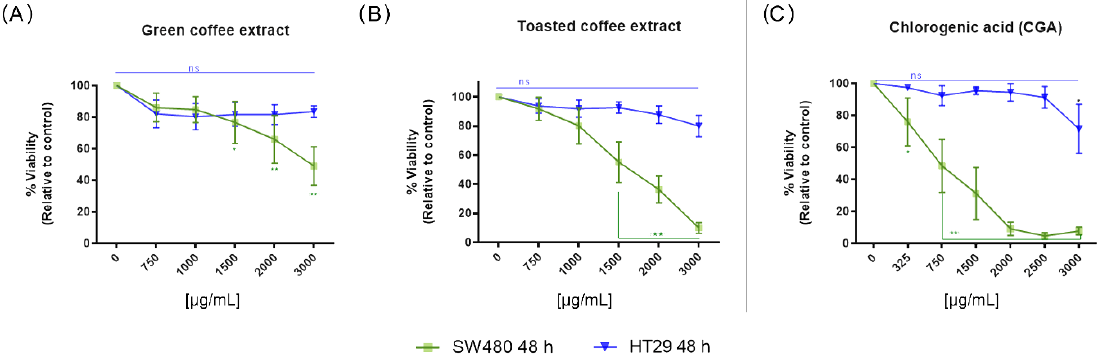
Figure 2. The cytotoxic activity at 48 h measured by MTT in the colorectal cancer cell lines SW480 and HT-29. Treatments with green coffee extract (GC) ( A ), toasted coffee extract (TC) ( B ), and CGA ( C ). Values are expressed as the mean ± SEM of at least three independent experiments. Two-way ANOVA, difference to non-treated cells, * p ≤ 0.05, ** p ≤ 0.01; ns: non-significant differ- ences. Table 2. Half maximal inhibitory concentration (IC50) values by MTT and SRB methods on SW480 and HT-29 cells treated with green and toasted coffee extracts (GC, TC) and chlorogenic acid (CGA).